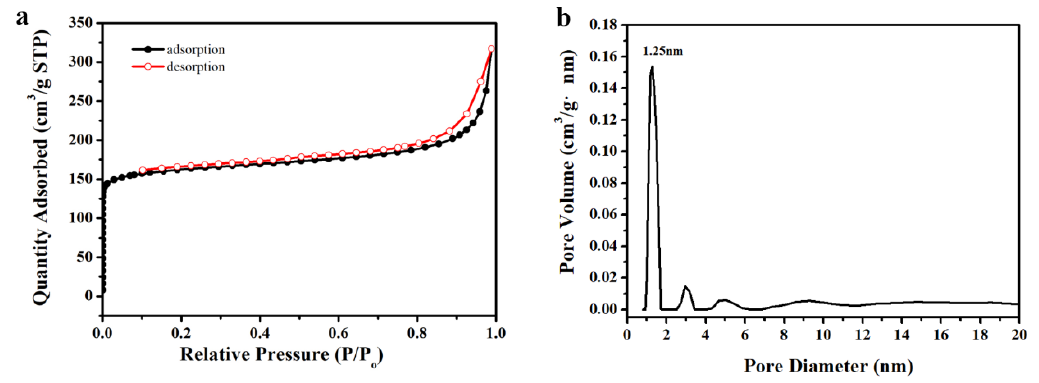
Figure 3. ( a ) Nitrogen adsorption-desorption isotherms of COF-K. ( b ) Pore-size distribution of